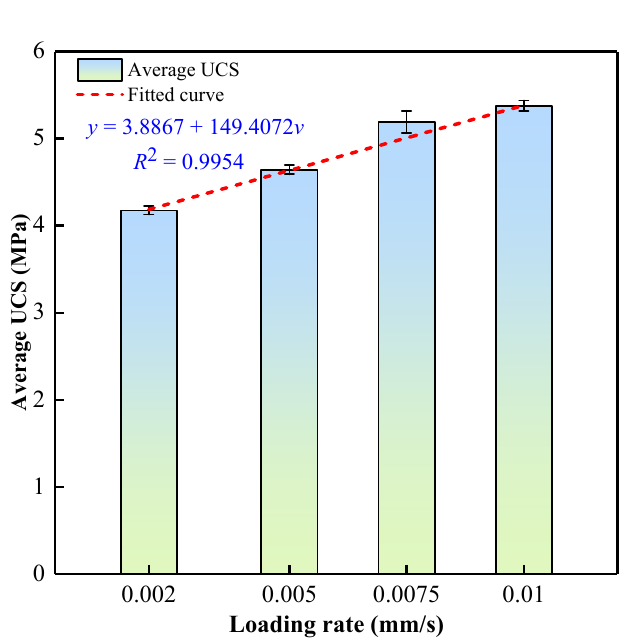
Figure 3. Relationship between average UCS and loading rate.